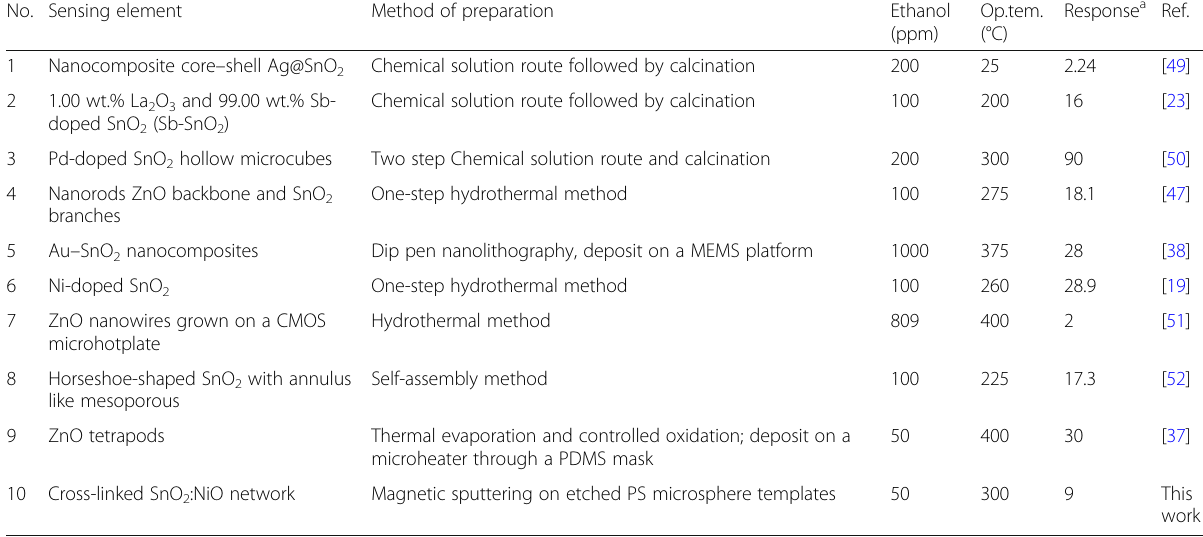
Table 1 Comparison of the sensing performance between the current work with previously reported results No. Sensing element Method of preparation Ethanol